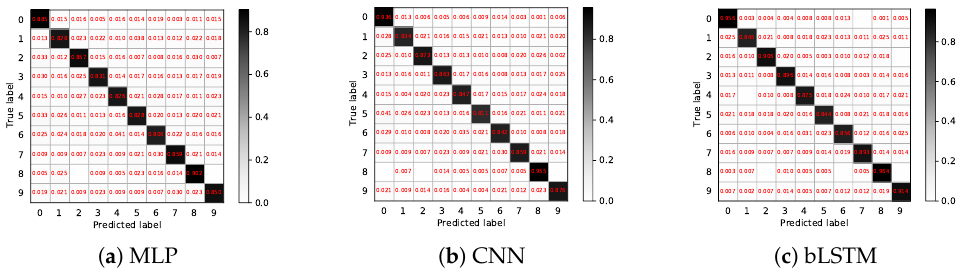
Figure 13. Confusion matrices of the three